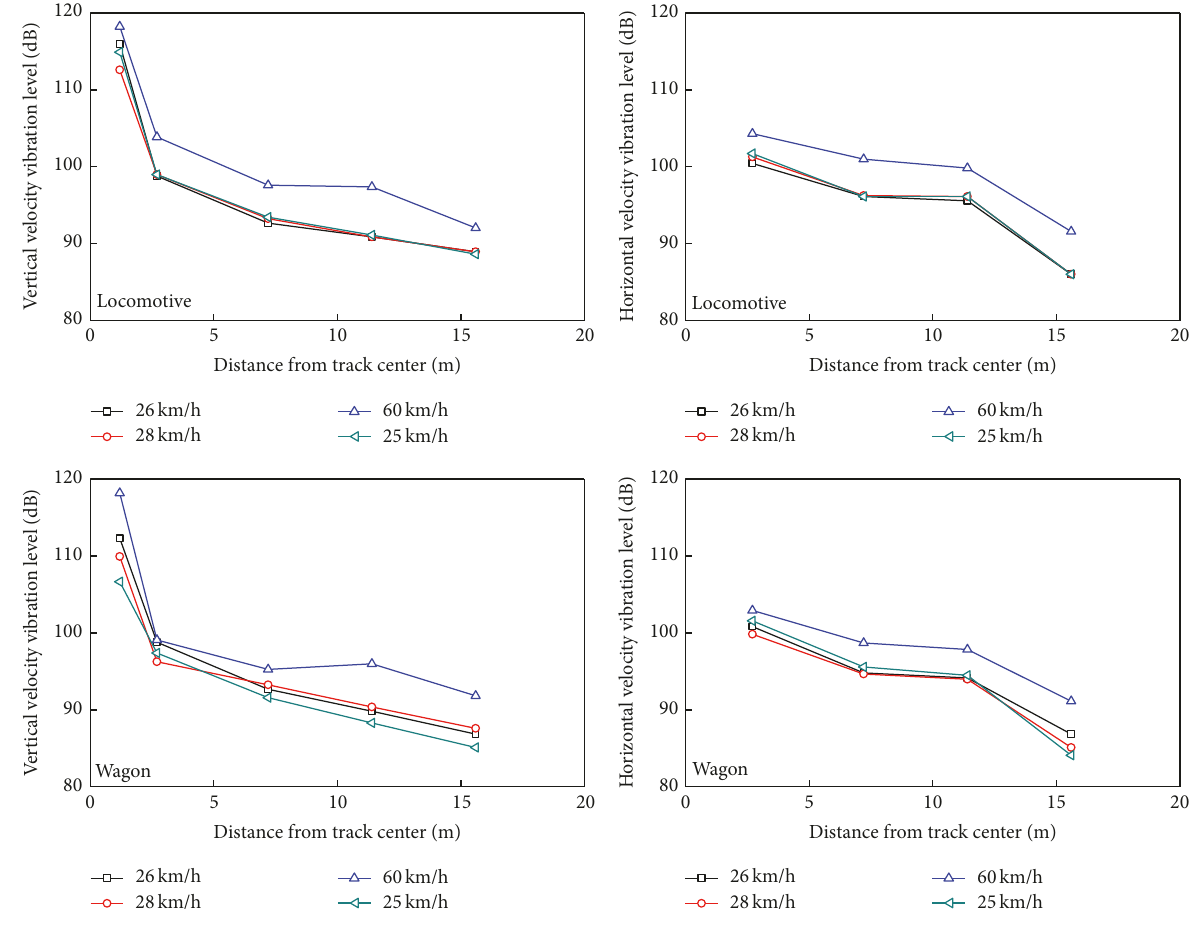
Figure 13: Comparison of vibration velocity level with various running speeds.